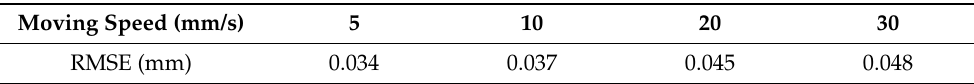
Table 1. The RMES in different moving speed of